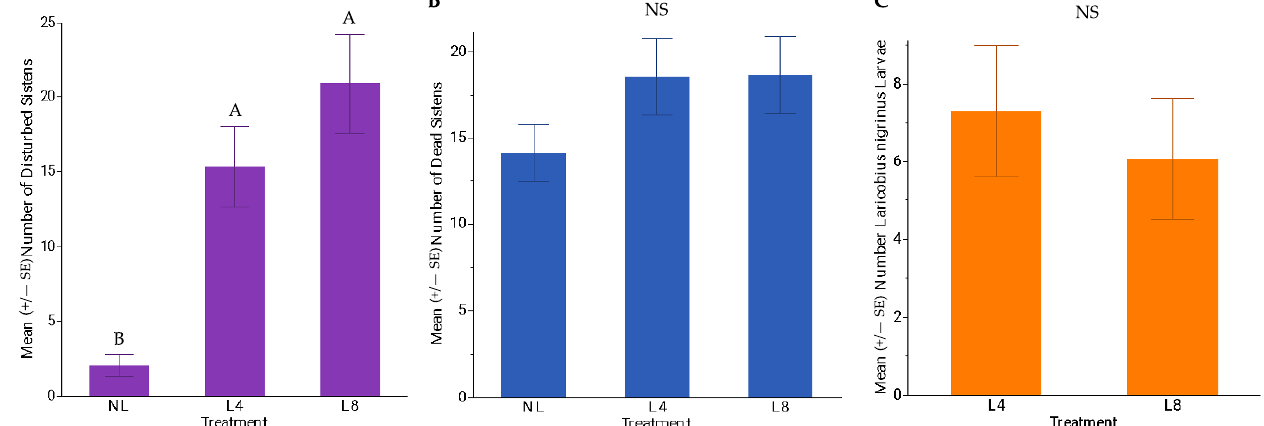
Figure 2. Experiment 1. ( A ) Mean (+/− SE) number of disturbed sistens across treatments. Different letters above standard error bars indicate significant ( p < 0.05) differences, Tukey post hoc adjustment. ( B ) Mean (+/− SE) number of sistens dead due to winter conditions across treatments. Letters NS above standard error bars indicates no significant differences ( p > 0.05). ( C ) Mean (+/− SE) number of Laricobius nigrinus larvae collected from treatment branches. Letters NS above standard error bars indicates no significant differences ( p > 0.05).